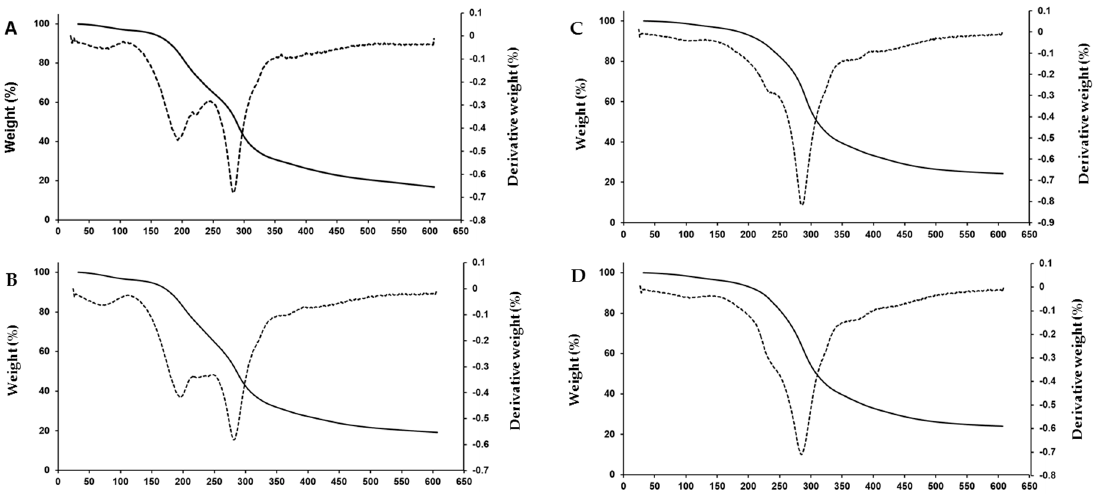
Figure 2. Thermogravimetric analysis (TGA) and derivative thermogravimetric (DTG) curves of chickpea flour films. ( A ) 3% glycerol, pH 7; ( B ) 3% glycerol, pH 10; ( C ) 1% glycerol, pH 7; ( D ) 1% glycerol, pH 10. Table 5. Thermogravimetric analysis results of chickpea flour